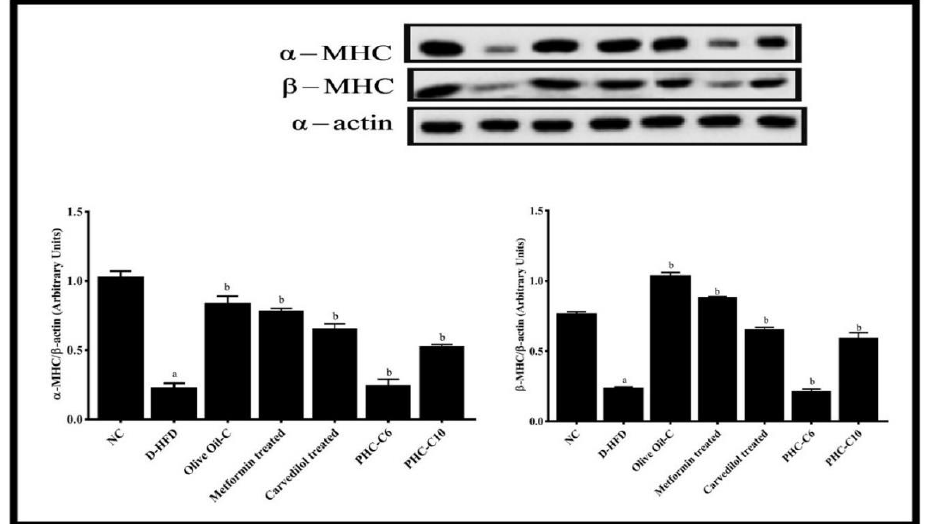
Figure 7. Western Blot α / β Myosin Heavy Chain (MHC) expression. All values are expressed as Mean ± SD (n = 6). The values were analysed bt one way ANOVA & followed by Tukey’s t -test and were found to be significantly different at (a,b) p < 0.05 when D-HFD-C was compared with NC & all other Treatment groups were compared with D-HFD-C. Where, NC is normal control; D-HFD-C is